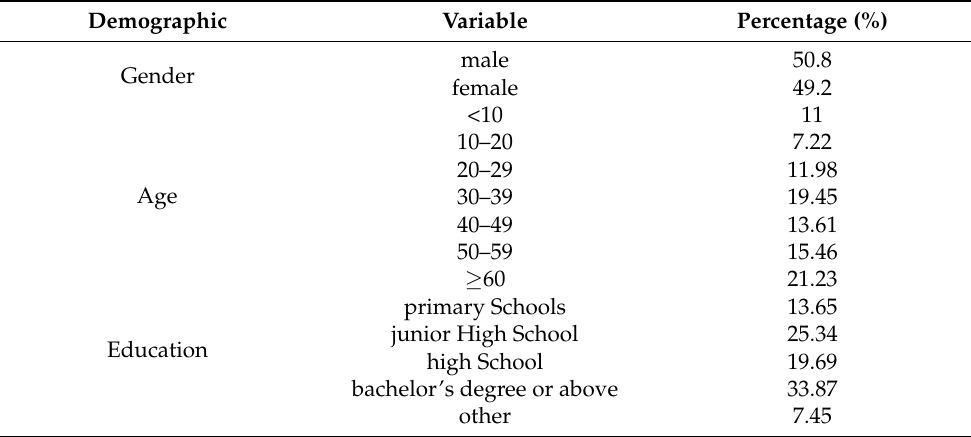
Table 2. Basic sociodemographic characteristics of Wuhan residents.